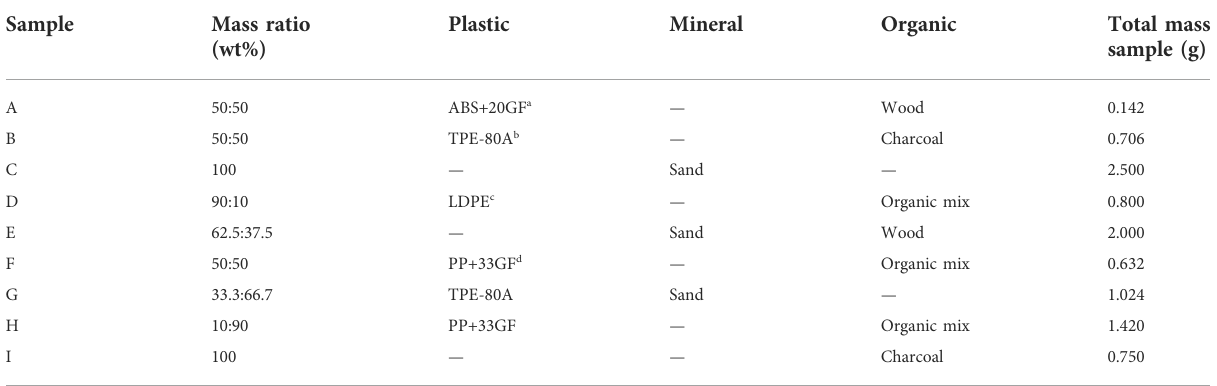
TABLE 1 Composition of test samples A –